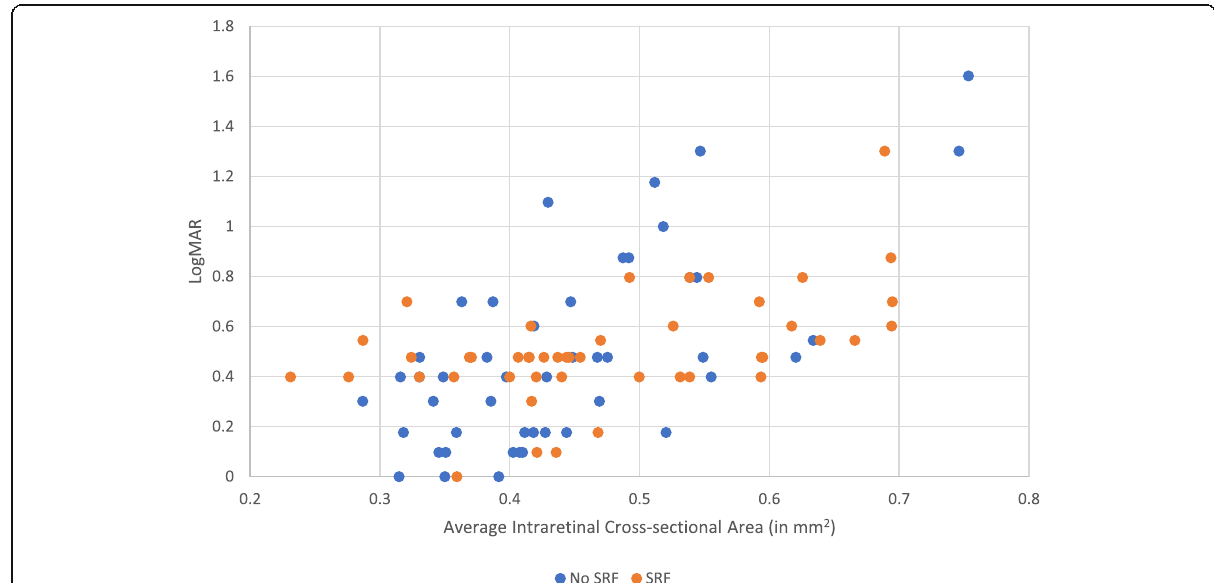
Fig. 2 Plot of average intraretinal cross-sectional area by LogMAR for eyes with and without SRF at presentation. The intraretinal cross-sectional area was strongly correlated to visual acuity in eyes with SRF (Spearman correlation coefficient 0.49, p < 0.001) and eyes without SRF (Spearman correlation coefficient 0.59, p <